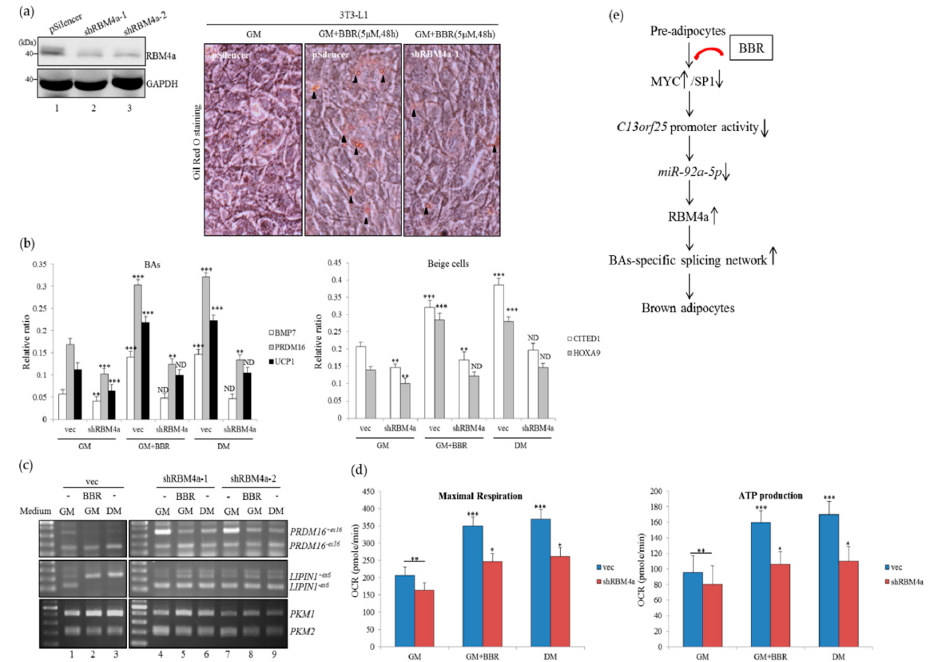
Figure 7. Depletion of RBM4a diminished the influence of BBR on beige adipogenesis. ( a ) 3T3-L1 cells were respectively transfected with the empty vector or targeting vectors against mRBM4a (shRBM4a-1 and 2). Total cell lysates were extracted 24 h post-transfection and subjected to immunoblot assays with indicated antibodies. Oil-Red-O staining was performed to monitor the lipid accumulation (arrowhead) in 3T3-L1 cells applied to the parallel transfection, followed by culturing in the